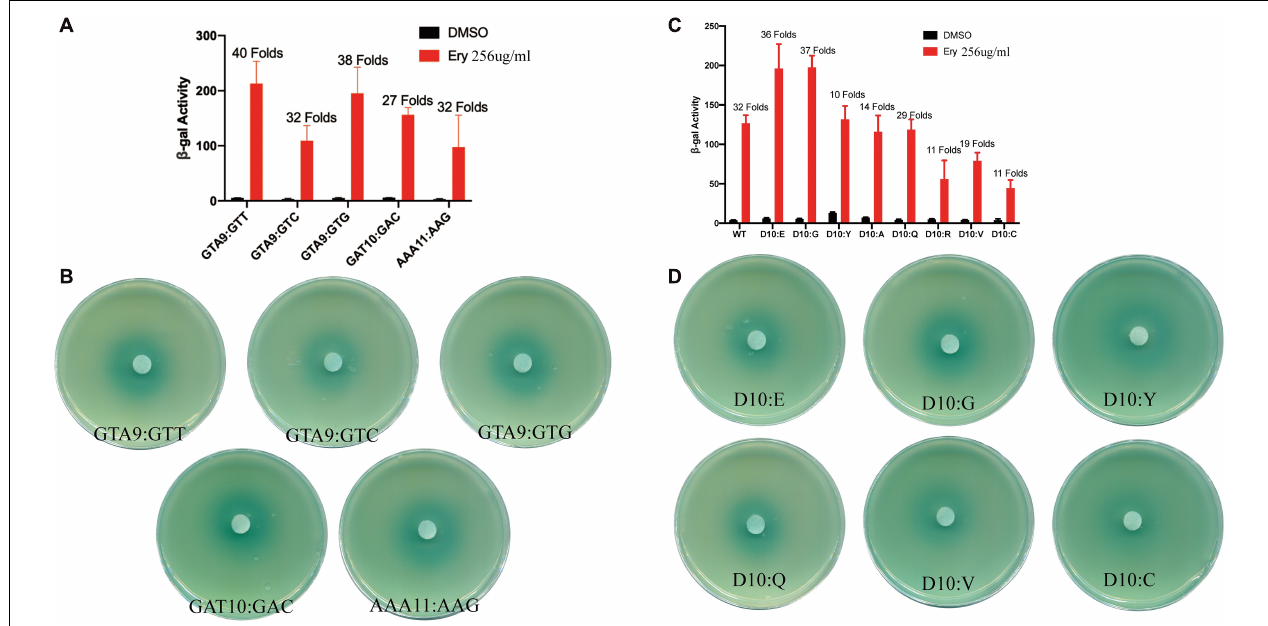
FIGURE 2 | Ribosome stalling efficiency in vitro is not consistent with the degree of induction in vivo. (A,B) β -Galactosidase activity and agar diffusion assays of various ermBL synonymous mutations following Ery exposure. Data are mean ± SEM from three independent experiments (unpaired two-tailed Student’s t -test). (C,D) β -Galactosidase activity and agar diffusion assays of the degree of Ery induction in vivo for the Asp10 mutation of ermBL . Data are mean ± SEM from three independent experiments (unpaired two-tailed Student’s t -test).